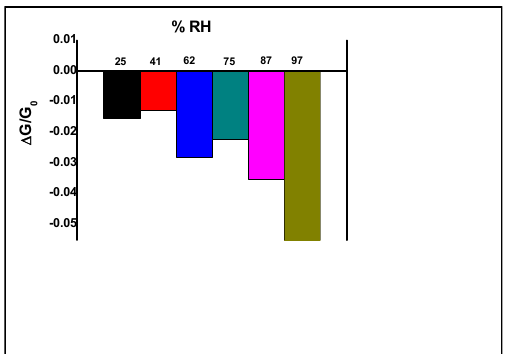
Figure 13. Response of the WS 2 sensor towards 240 ppm of NH 3 at room temperature under various humidity conditions (25, 41, 62, 75, 87 and 97%).